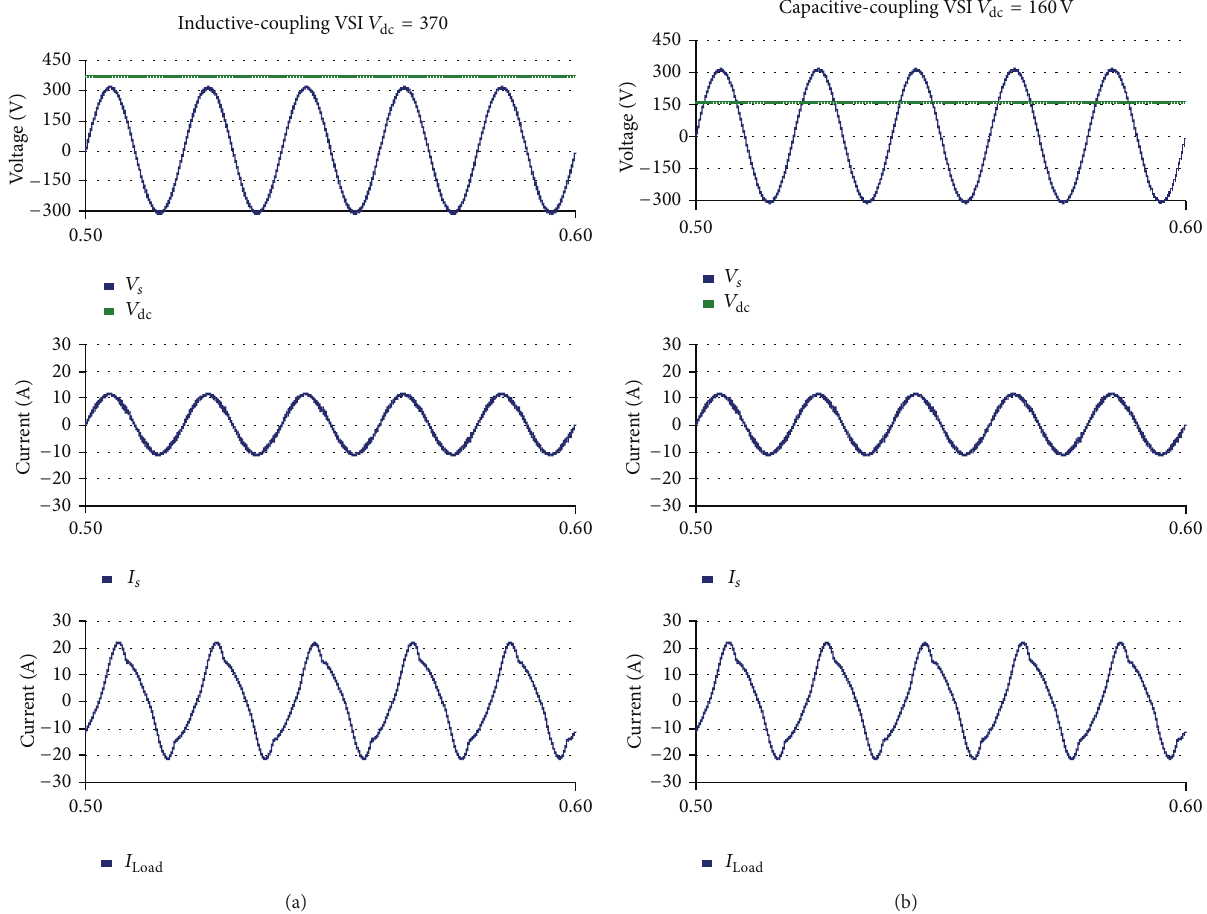
Figure 9: Simulation results with harmonic compensation: (a) inductive-coupling VSI and (b) capacitive-coupling VSI.